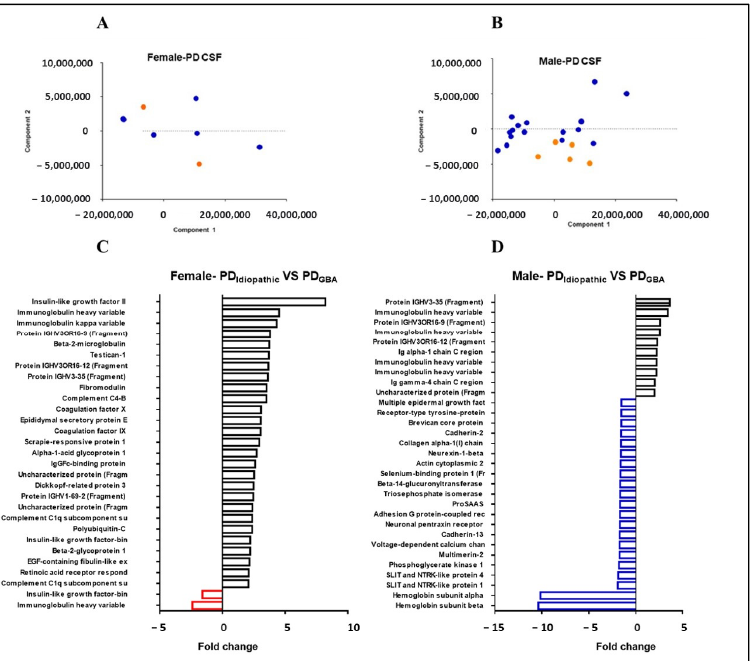
Figure 4. Effect of gender on CSF proteome in PD patients: Principal Component Analysis shows clusters for ( A ) female and ( B ) male cases with (blue circles) and without GBA mutation (orange circles). The column bar graph depicts the targets that show two-fold or higher fold change in PD Idiopathic ( C ) female and ( D ) male cases in comparison to the patients carrying a GBA mutation. The red and blue columns represent the downregulated proteins in female and male patients respectively.